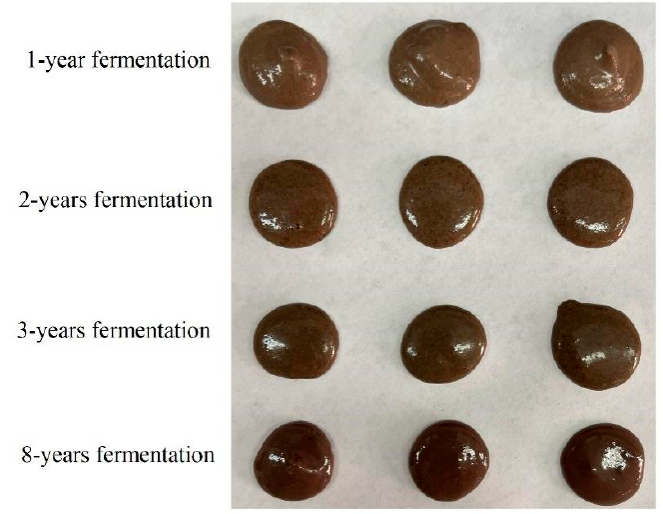
Figure 1. Appearance of shrimp paste at fermented for 1, 2, 3, and 8 years. Table 2. Color analyses of shrimp paste samples during 1, 2, 3, and 8 years of fermentation.